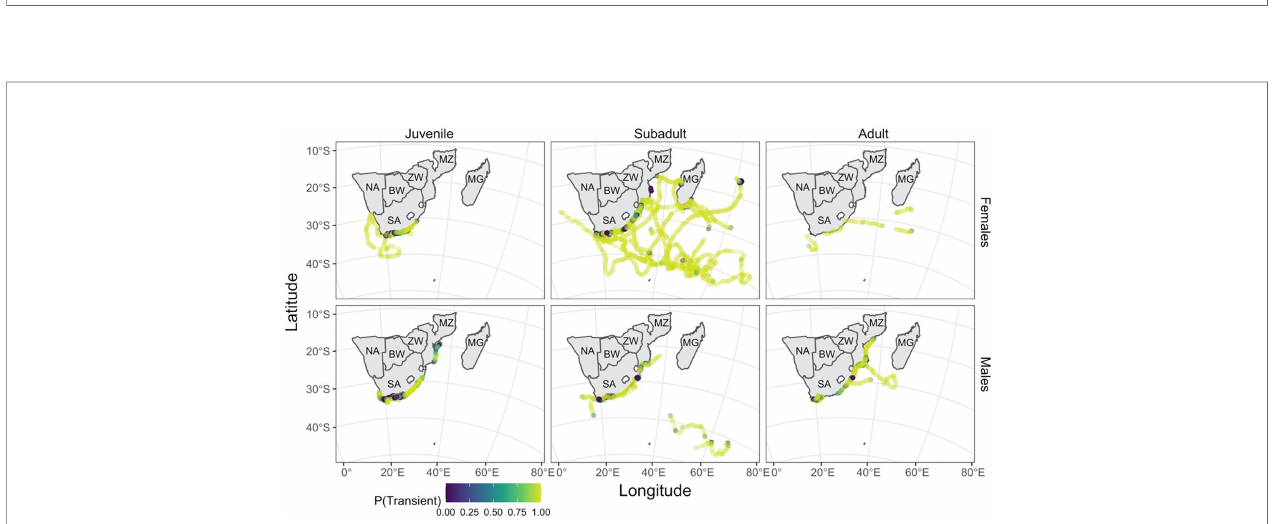
FIGURE 4 | Predicted shark locations are coloured by the probability of a given location belonging to the transient state, where lighter locations indicate a high probability of being transient. This illustrates the level of uncertainty in state assignment; the closer the colour to either end of the colour scale, the greater the certainty in state assignment. The tracks are separated here by life stage based on size (juvenile: left column, subadult: middle column, adult: right column) and by sex (females: top row, males: bottom row). Country codes are shown on the map: SA, South Africa; NA, Namibia; BW, Botswana; ZW, Zimbabwe; MZ, Mozambique; MG,